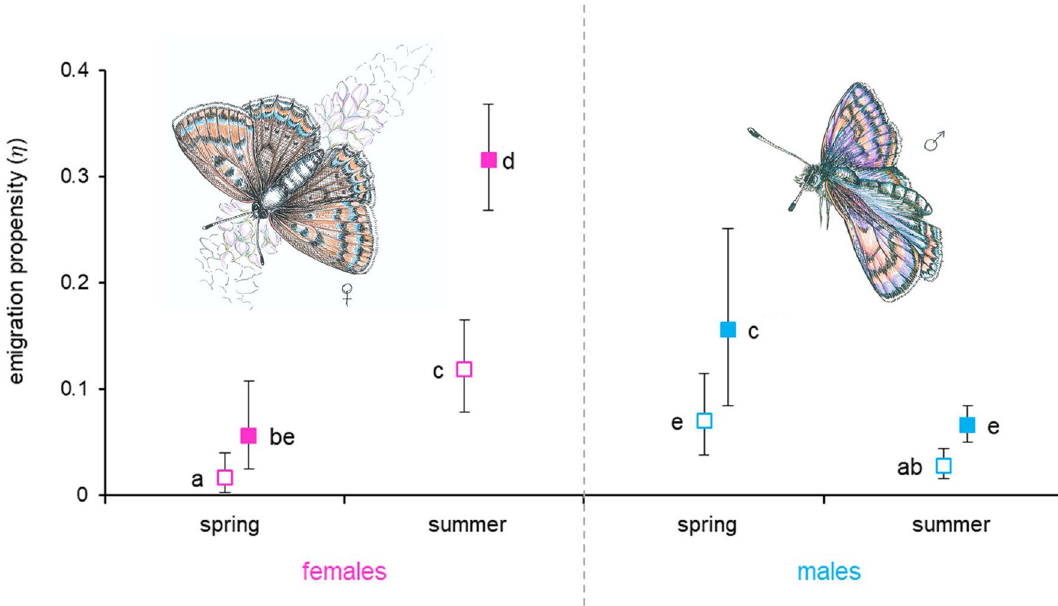
Figure 1. Between-season variation in emigration propensity of L. helle adults of both sexes in 2018 (empty symbols) and 2019 (solid symbols). The estimate values are presented with their 95% confidence intervals; the values statistically different (at P < 0.05) from each other are marked with different alphabet